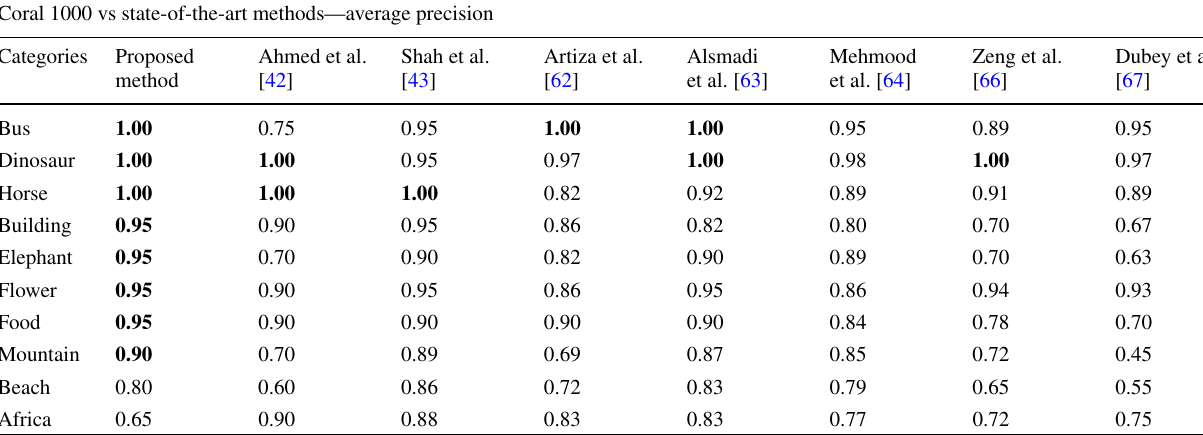
Table 4 Coral 1000 vs state-of-the-art methods—average precision Coral 1000 vs state-of-the-art methods—average precision